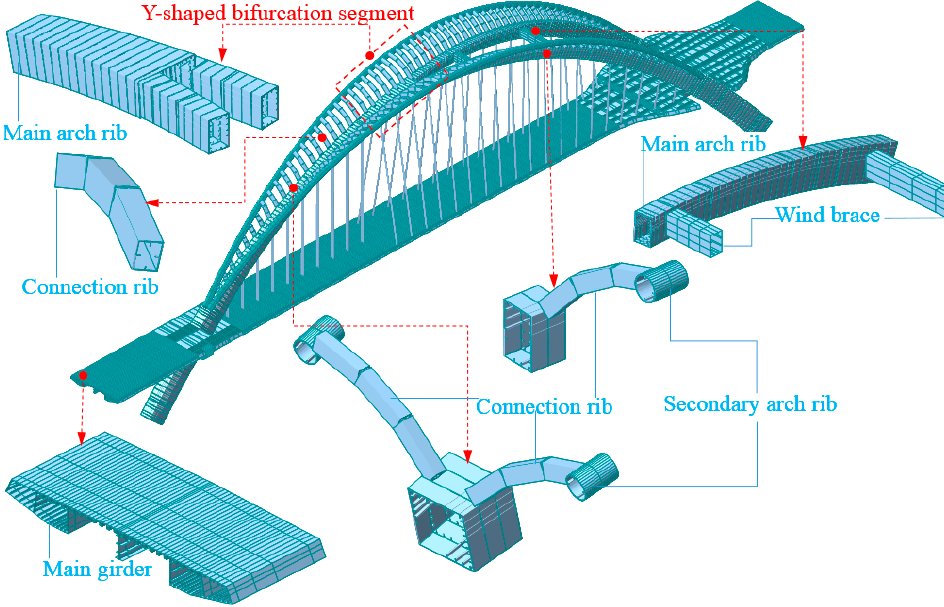
Figure 8. Numerical calculation model. Table 2. Mechanical property parameters of bearings.